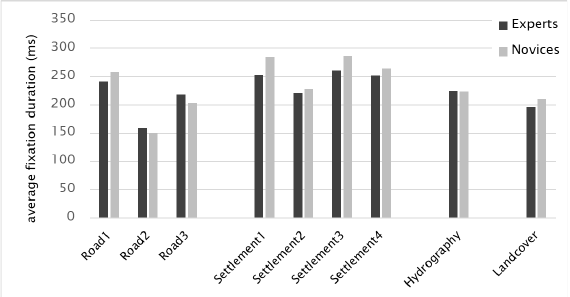
Figure 16. Average fixation duration (dark bars: experts, light bars